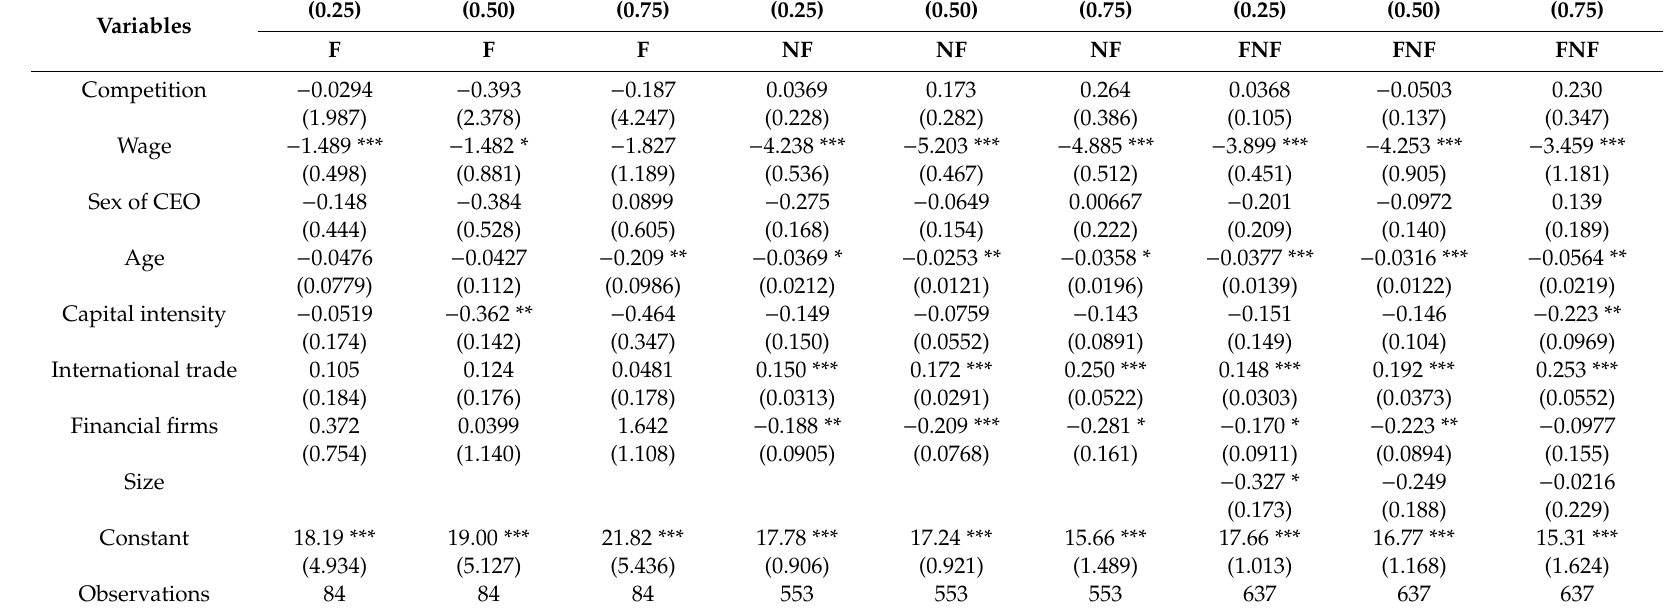
Table 7. Quantile regression results for financial (F) and nonfinancial firms